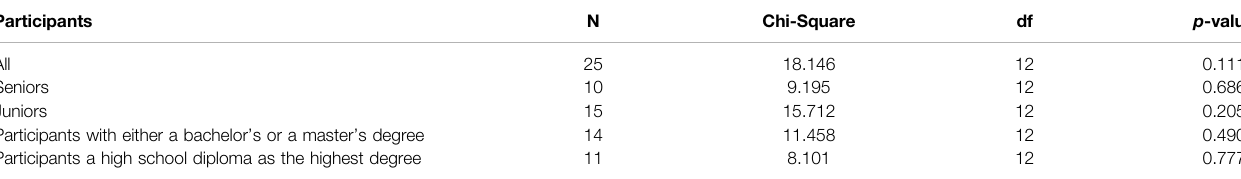
TABLE 5 | Friedman test results.